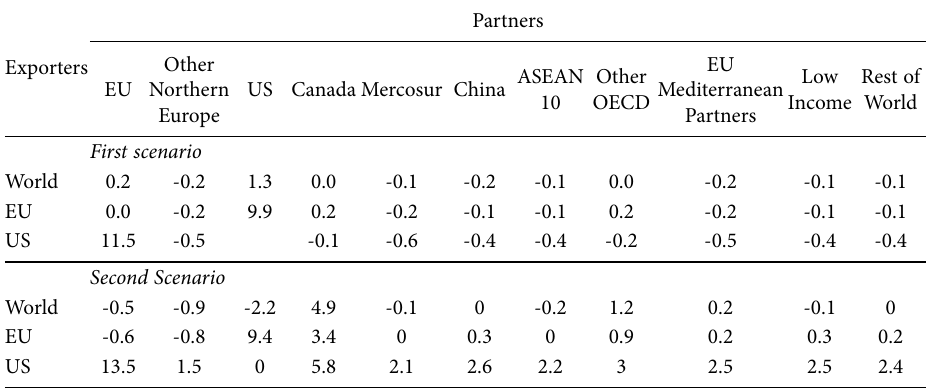
Table A3. Export volume by region for “livestock products” [% Change].